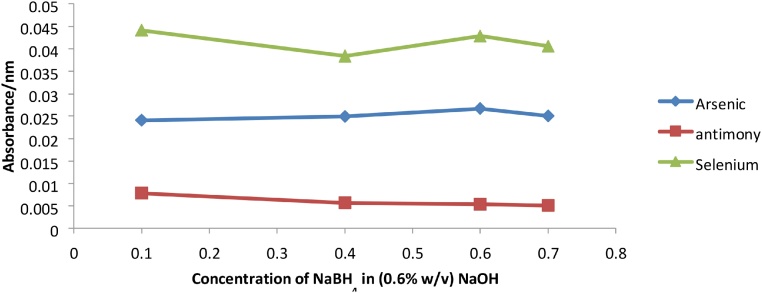
Graph of absorbance vs NaBH4 concentration for As, Sb and Se.